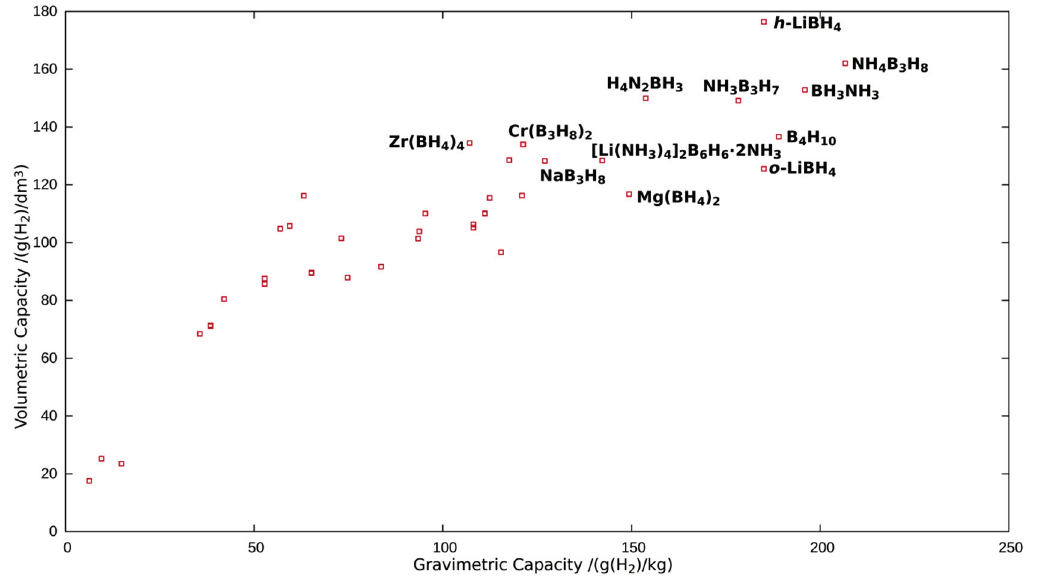
Figure 6. Plot of the compounds in the boron-hydrogen system (excluding C-, O-, P- and S-containing substances; red open squares) emerging from the COD. Some of the most promising individual materials are indicated (for references, see the